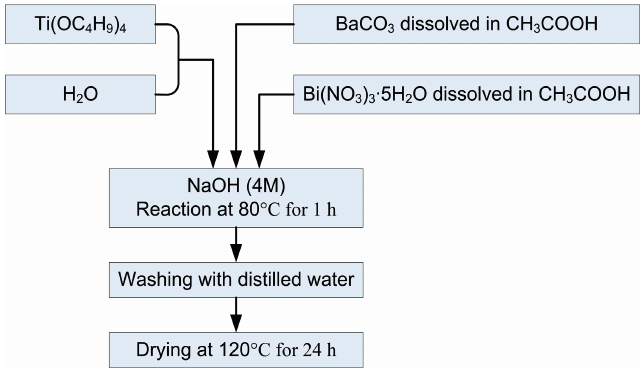
Figure 3. Scheme of the bismuth doped barium titanate (BBT) powder synthesis